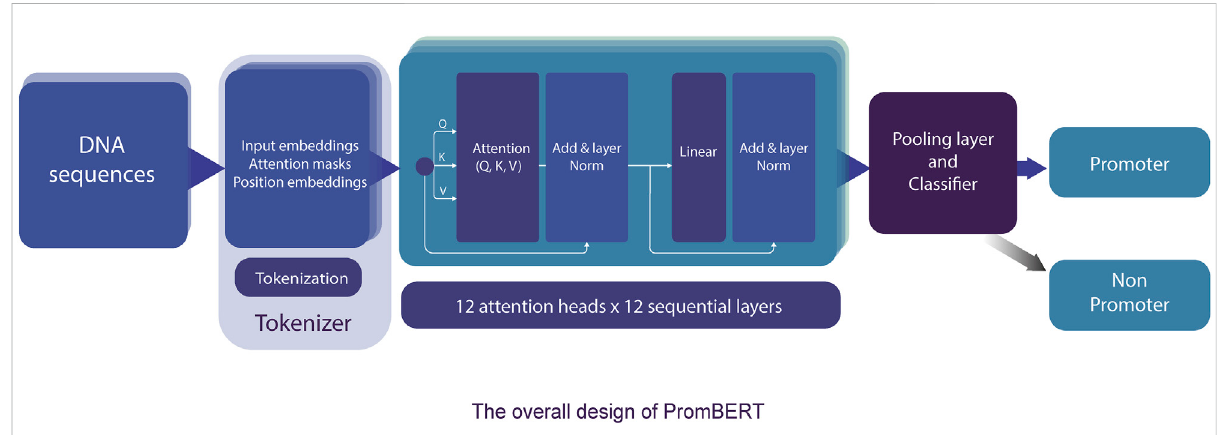
FIGURE 3 The detailed model architecture of PromBERT for promoter prediction. DNA sequences of fi xed length are tokenized using a custom 1bp tokenizerandfedinto144attentionmodules.Basedonthe fi naltensorsinthepoolinglayer,theclassi fi ercalculatestheprobabilitiesofpromoterand non-promoter using the sigmoid function. Backpropagation was conducted using binary cross entropy loss.